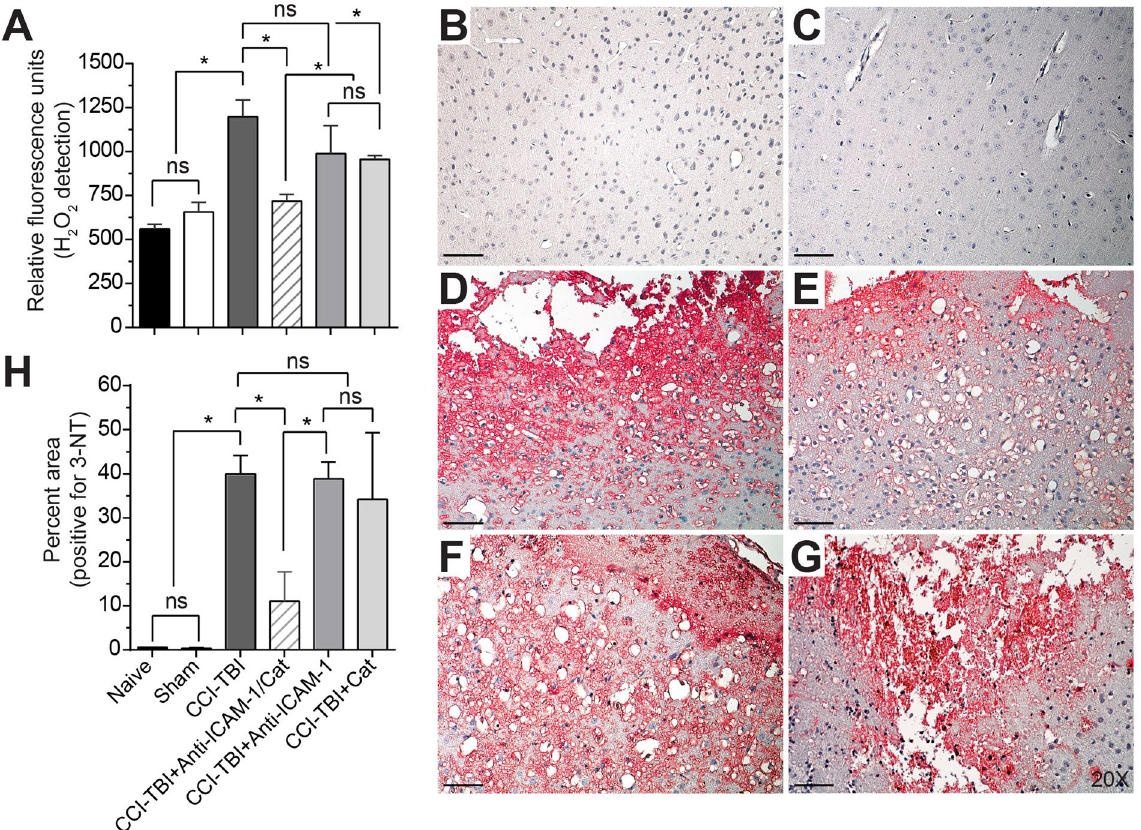
Figure 3. CCI-TBI results in increased hydrogen peroxide production and 3-nitrotyrosine detection in the ipsilateral cortex area of impact. ( A ) OxiSelect ™ Hydrogen Peroxide/Peroxidase Assay Kit was used to measure hydrogen peroxide levels in fresh mouse cortical tissue ipsilateral to the area of impact 4 hrs following CCI- TBI, CCI-TBI + anti-ICAM-1/catalase, catalase only, and antibody only administration or from naive and sham controls. The naive condition provides basal hydrogen peroxide levels in uninjured cortical tissue which are not significantly different from sham. CCI-TBI results in a nearly 3-fold increase in hydrogen peroxide level detection. Anti-ICAM-1/catalase quenches hydrogen peroxide levels in the area of injury to physiological levels comparable to that of naive and sham, an effect not achieved with anti-ICAM-1 antibody and catalase alone. Immunohistochemical chomogen staining of 3-NT demonstrates increased tyrosine nitration following CCI- TBI ( D ) compared to naive and sham controls ( B and C , respectively). Anti-ICAM-1/catalase significantly decreased 3-NT detection ( E ). 3-NT levels in anti-ICAM-1 antibody and catalase only groups did not significantly differ from CCI-TBI alone ( F and G , respectively). Positive signal detection was pseudo-colored red for better visualization. All images taken at 20X. Scale bar equals 50 microns. ( H ) Quantification of 3-NT signal detection was analyzed by percent area and normalized to total tissue area per image. Data are presented as mean ± SD. (Ordinary one-way ANOVA with multiple comparisons for hydrogen peroxide data F = 25.95, P < 0.0001 and 3-NT data F = 21.07, P <